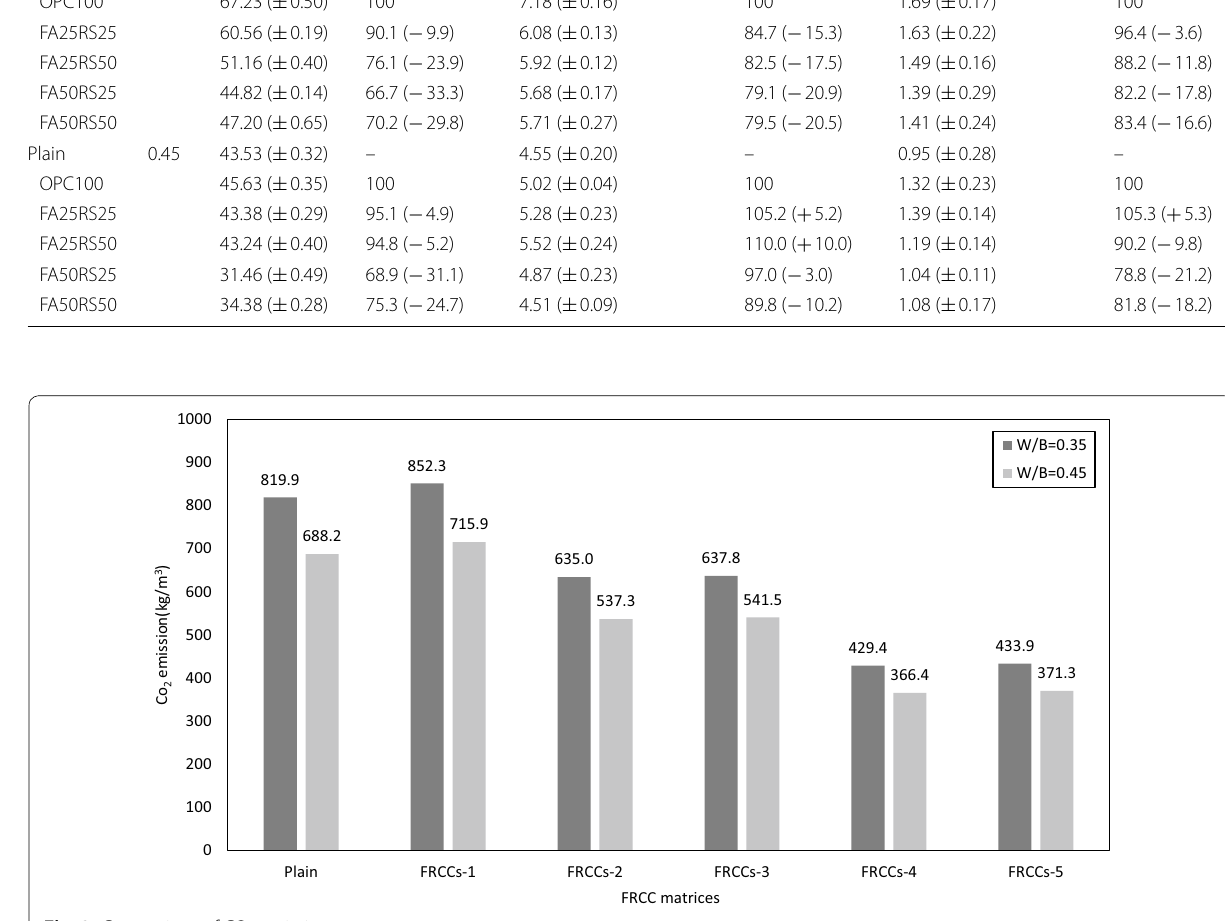
Fig. 3 Comparison of CO 2